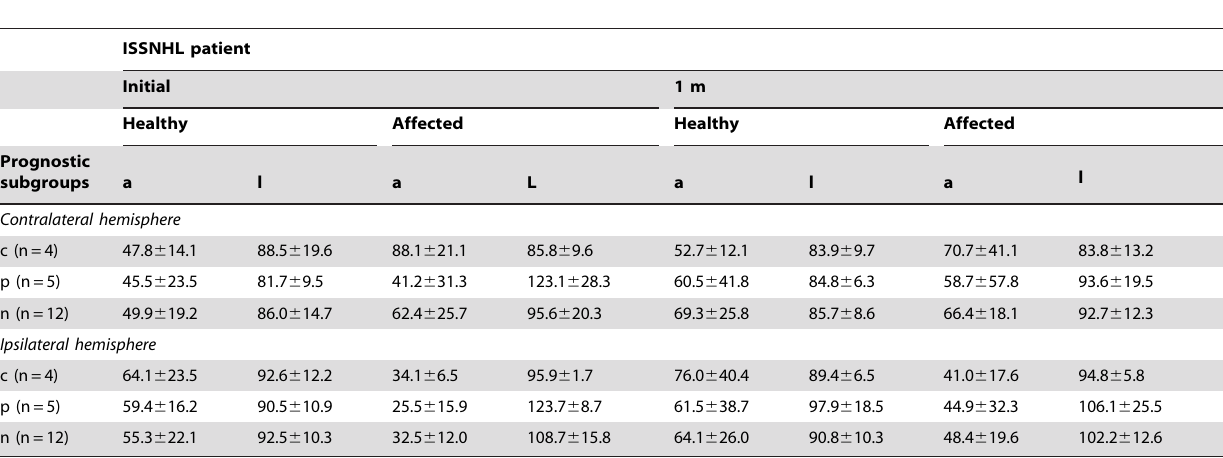
Table 3. Amplitude and latency of peak dipole moment for N100m (m 6 sd) in prognostic subgroups.